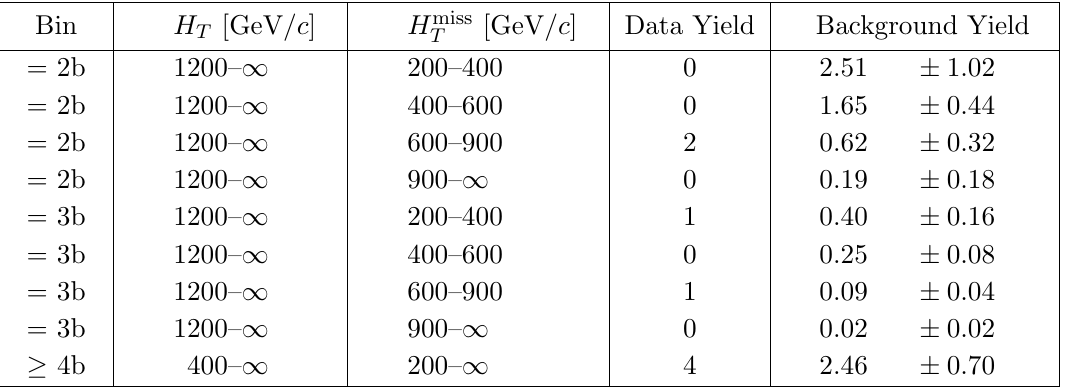
Table 3. Data and background yields for the bins used in this analysis, taken from [5].